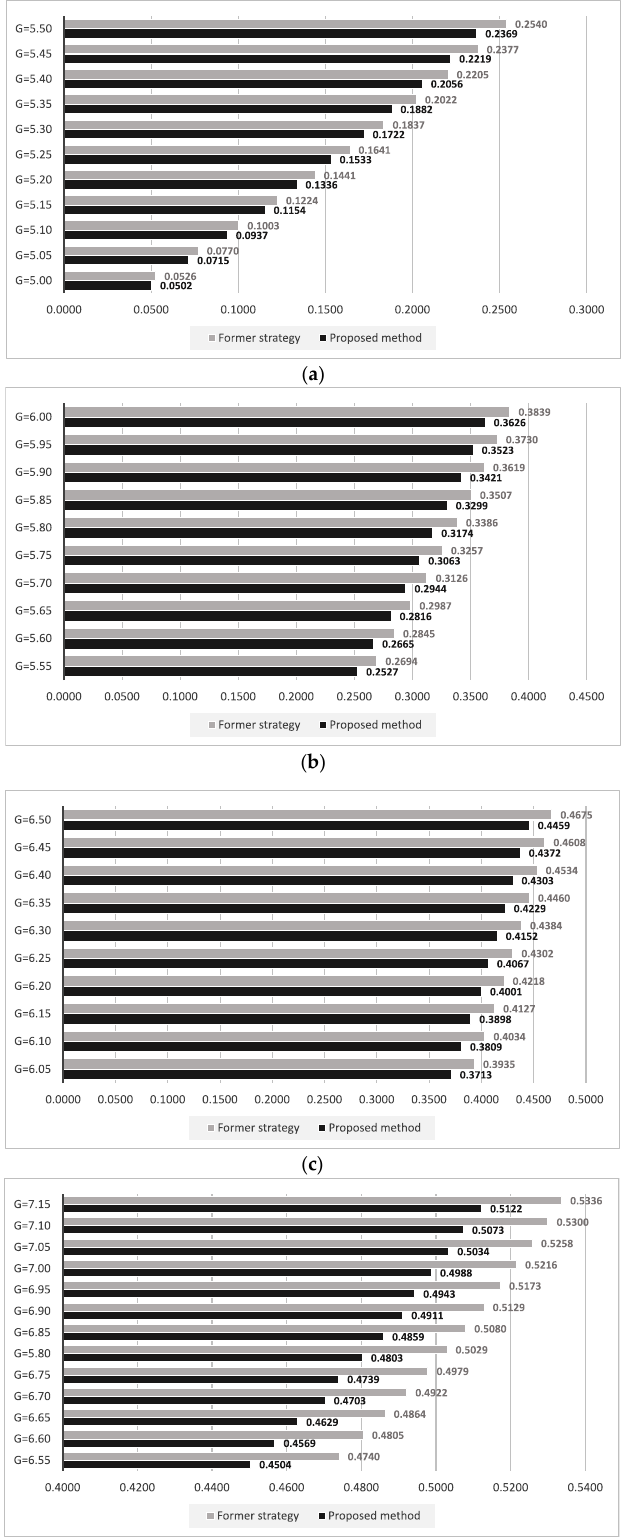
Figure 7. Input current ripple obtained from the former strategy and the proposed method: ( a ) for voltage gain from 5.00 V to 5.50 V; ( b ) for voltage gain from 5.55 V to 6.00 V; ( c ) for voltage gain from 6.05 V to 6.50 V; and ( d ) for voltage gain from 6.65 V to 7.15 V.